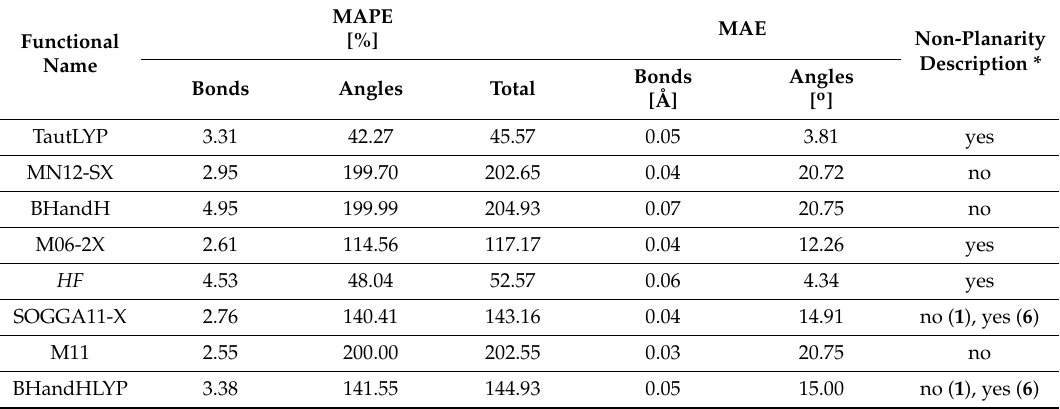
Table 3. MAE and MAPE of the structural elements description of the tautomers of 1 and 6 .